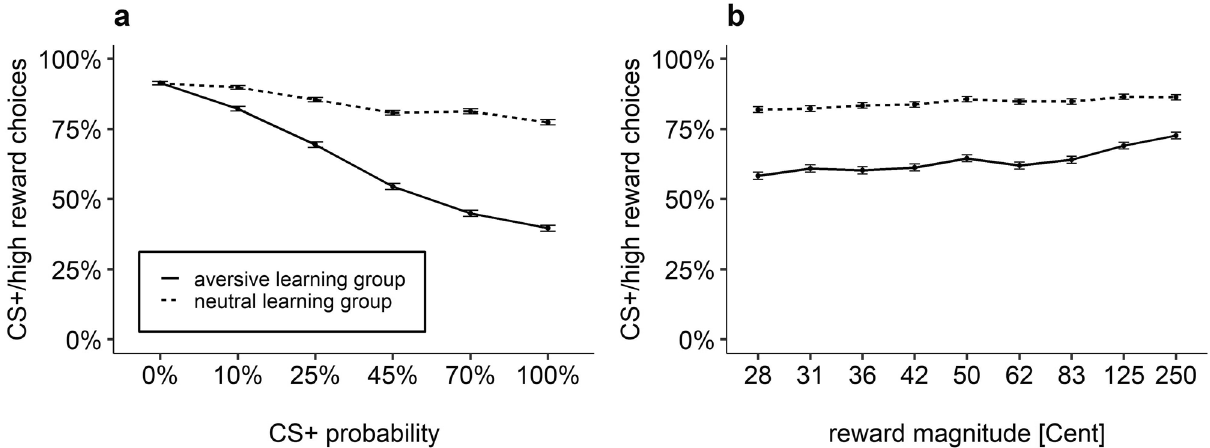
Figure 2. Mean percentage of CS+/high reward choices (with standard error) in relation to ( a ) CS+ probability and ( b ) reward magnitude of the CS+/high reward option for the neutral and the aversive learning